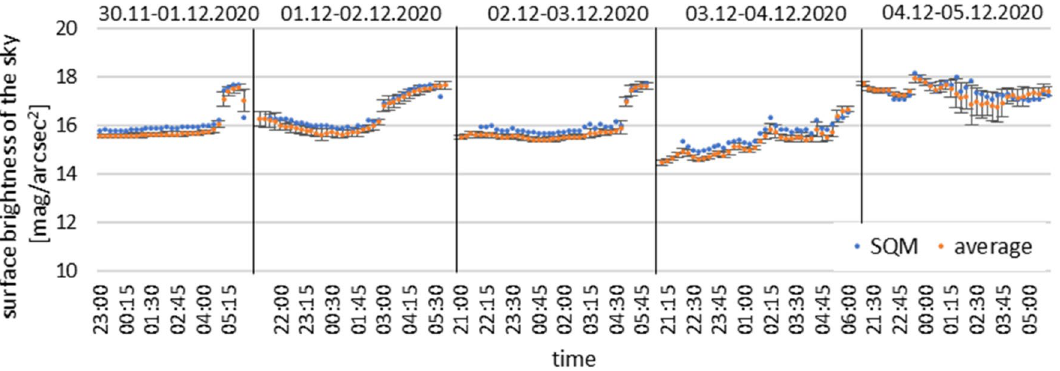
Figure 12. Summary of the average measurement results of all devices with the results measured with the SQM photometer.